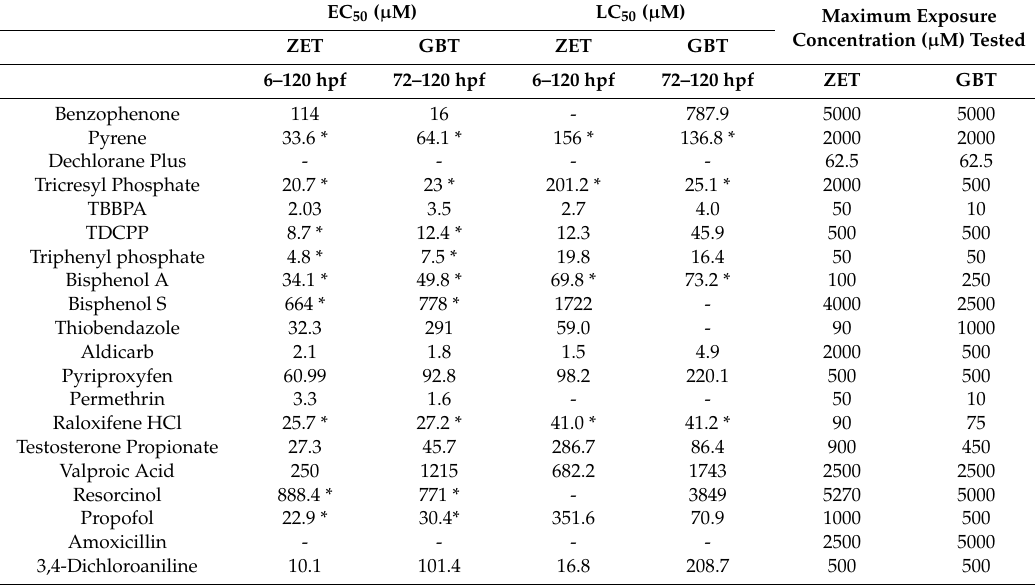
Table 3. Summary of EC 50 and LC 50 data for both the ZET (6–120 hpf exposure) and GBT assays (72–120 hpf exposure). For each compound the EC 50 and LC 50 dose curves from the two assays were statistically compared using an extra sum of squares F-test ( p > 0.05). Curves from both the ZET and GBT assays that are statistically similar are denoted with an asterisk (*). All values are shown in µ M and a hyphen (-) denotes that an EC / LC 50 value could not be determined. The maximum exposure concentration tested in both assays is